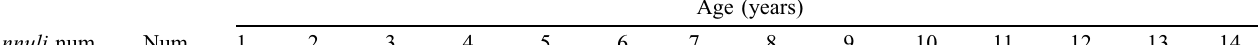
Table 3. Mean total length at age ( TL ), the number of specimens ( n ) and 95% con fi dence intervals ( Cl ) for male, female and hermaphrodites and pooled sexes of Pagrus pargus from southern Brazil sampled between 1976 and 1985. The results of the Kruskal – Wallis test between sexes by age are shown in the right column. The pooled sexes number includes non-sexed specimens. Age class Males Females Hermaphrodites